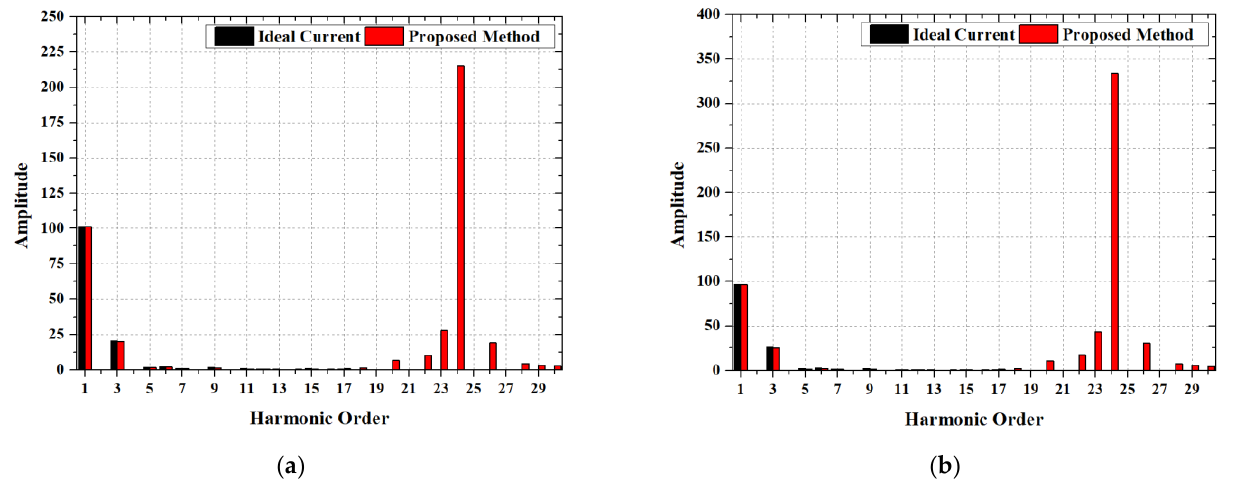
Figure 9. Iron loss comparison between the ideal current source analysis and the proposed method for cases 3 and 4. ( a ) Case 3; ( b ) Case 4. Table 8. Case 5:. 99 Nm at 3000 rpm.